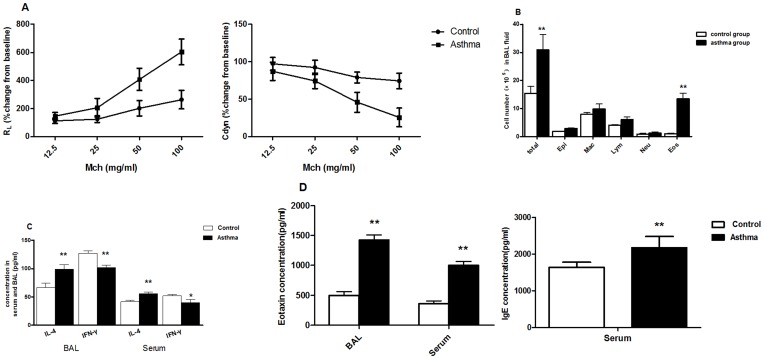
OVA-sensitized asthmatic rat models were established successfully.Airway function was detected and BAL fluid and serum were collected and evaluated by ELISA. A, RL and Cdyn values were obtained in response to increasing concentrations of inhaled MCh, as described in material and methods. Data represented mean±SEM (n = 20 in each group). *p<0.05. B, Cellular composition of BAL fluid. C, Cytokine levels in BAL fluid and serum. D, Eotaxin levels in BAL fluid and serum. IgE levels in serum. Total, total cells; Epi, epithelium; Mac, macrophages; Lym, lymphocytes; Neu, neutrophils; Eos, eosinophils. Date represent the mean±SEM (n = 20 in each group). *p<0.05, **p<0.01 significant differences comparing asthmatic group and control group.